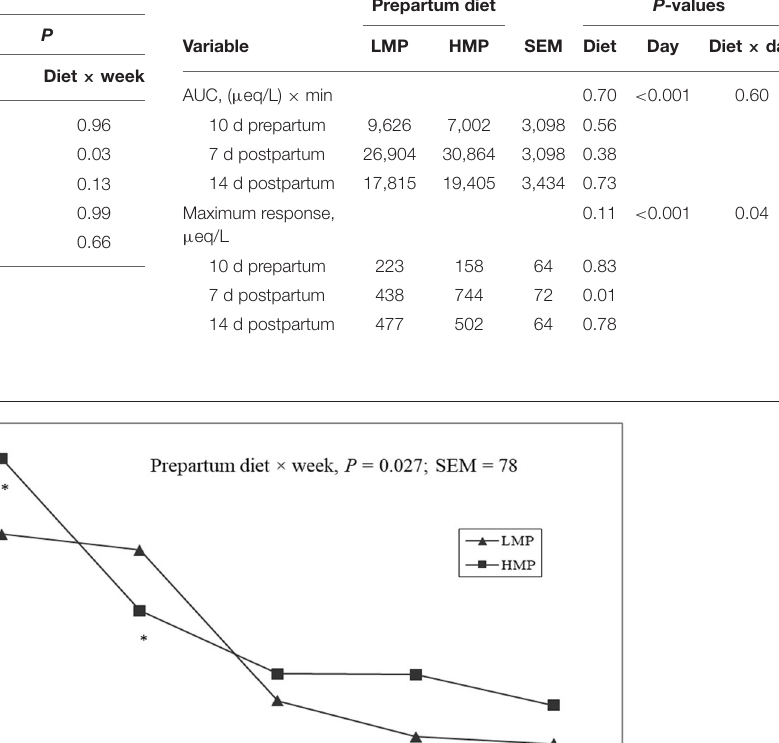
TABLE 5 | Postpartum concentrations of compounds in plasma for cows fed low (L) or high (H) amounts of metabolizable protein (MP) prepartum.